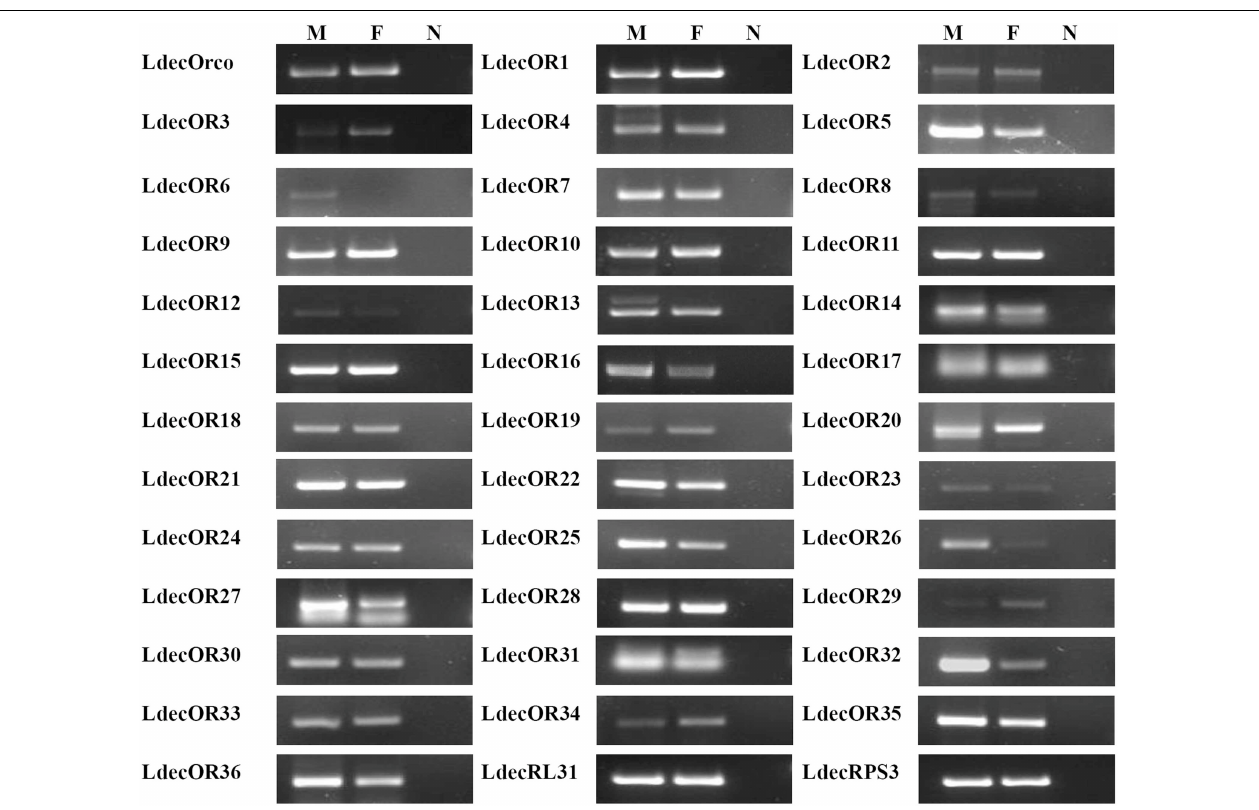
FIGURE 7 | Sex-specific expressions of candidates LdecORs . M, male antennae; F, female antennae; N: negative